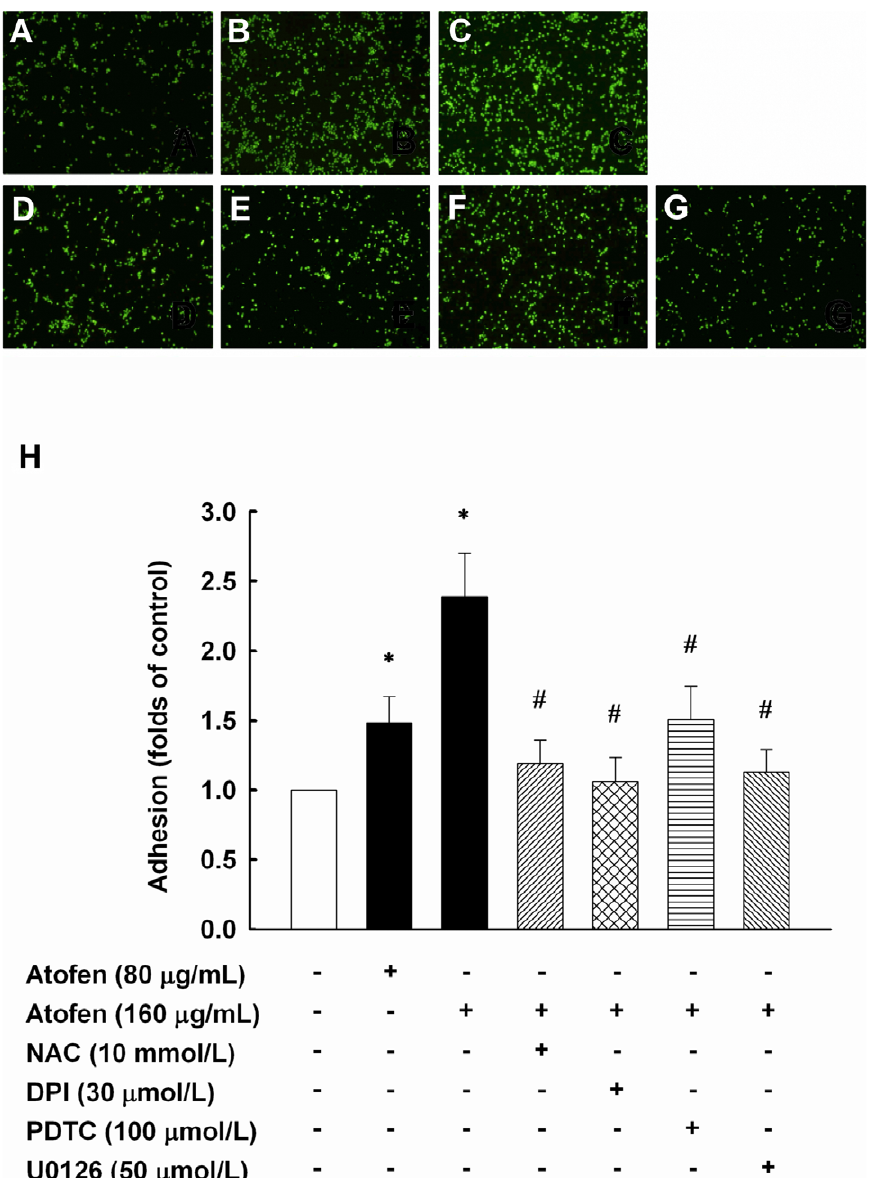
Figure 4. Iron enhanced adhesiveness of human MNCs to HAECs. HAECs were treated with ferric chloride hexahydrate (Atofen) with or without NAC (100 mmol/L), DPI (30 m mol/L), PDTC (100 m mol/L), and U0126 (50 m mol/L) for 4 hours. In upper panel, HAECs were unstimulated (control) (A), or stimulated by 80 m g/mL of Atofen alone (B), by 160 m g/mL of Atofen alone (C), and by co-treatment with 160 m g/mL of Atofen and NAC (D), DPI (E), PDTC (F), U0126 (G), respectively. Cell adherence was expressed as the fold difference over the untreated control. Values are expressed as mean 6 SEM. * P , 0.05 compared with baseline. # P , 0.05 compared with 160 m g/mL Atofen for 4 h. Abbreviations: DPI, diphenyleneiodonium; HAECs, human aortic endothelial cells; NAC, N-acetylcysteine; PDTC, pyrrolidine